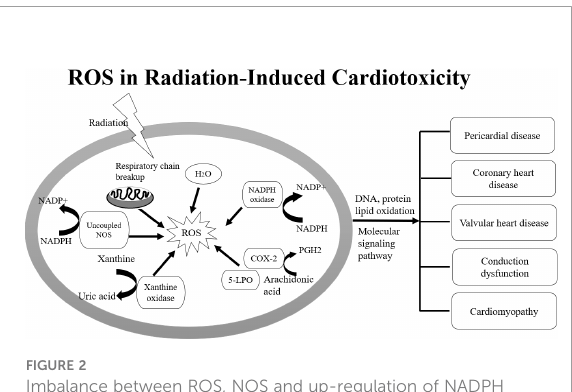
FIGURE 2 Imbalance between ROS, NOS and up-regulation of NADPH oxidases are involved in DNA damage in carditis after